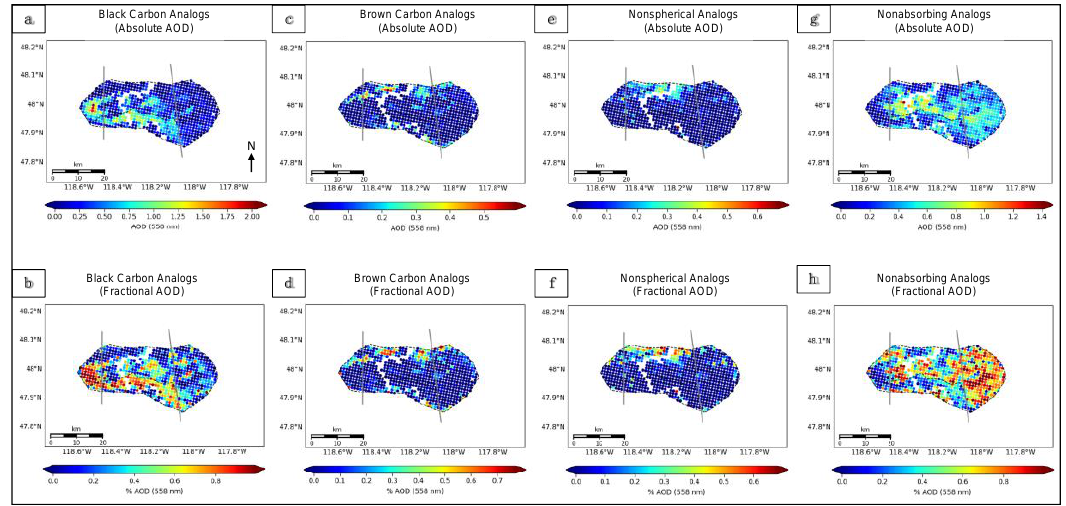
Figure 4. The absolute and fractional AOD (558 nm) of various MISR-RA aerosol components for the Williams Flats Fire on 06 August, 2019, where ( a , b ) are the sum of all spectrally “flat” or BC-like components, ( c , d ) are the sum of all spectrally “steep” or BrC-like components, ( e , f ) are the sum of all non-light-absorbing components, and ( g , h ) are the non-spherical, dust-like components. Fractional plots are given as a fraction of 1. Note: scales differ between panels.